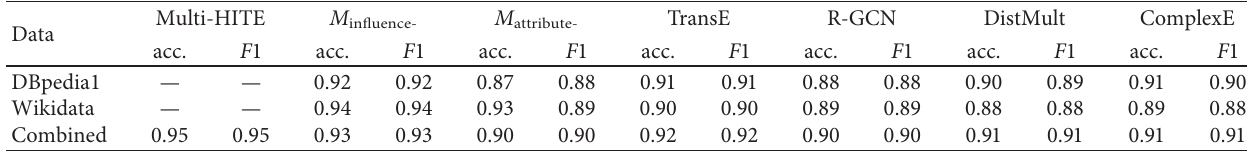
Table 3: Performance of link prediction from all the models on multiple